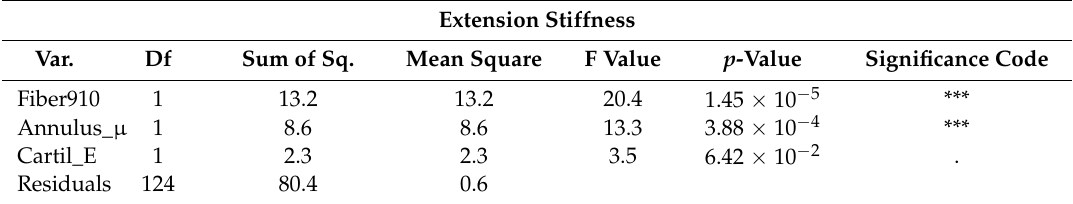
Table 18. ANOVA table for an extension stiffness linear